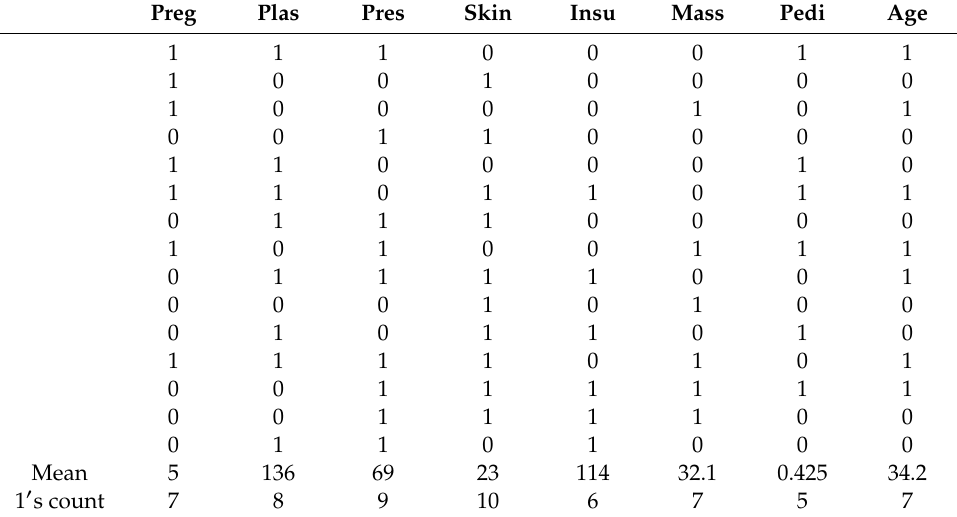
Table 12. Calculation of 1 (cid:48) s count for each column